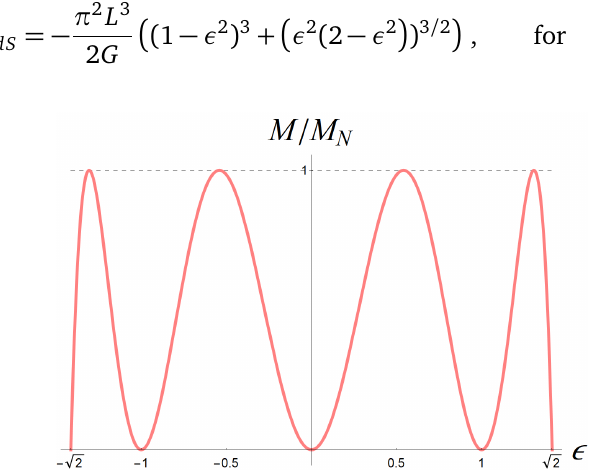
Figure 12: Mass in units of M